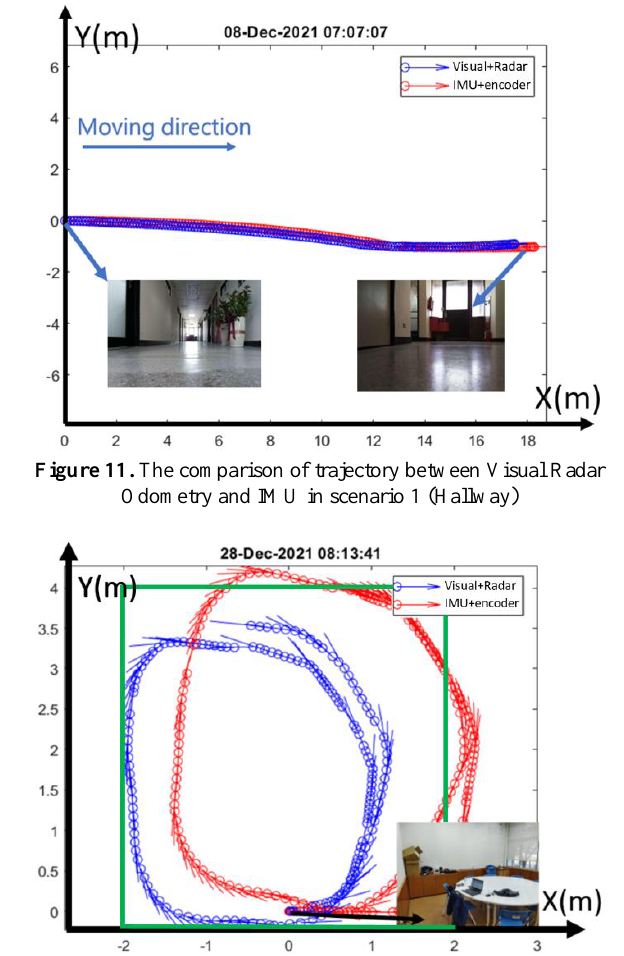
Figure 12. The comparison of trajectory between Visual Radar Odometry and IMU in scenario 2 (Conference room). The Green box indicates the boundaries of the